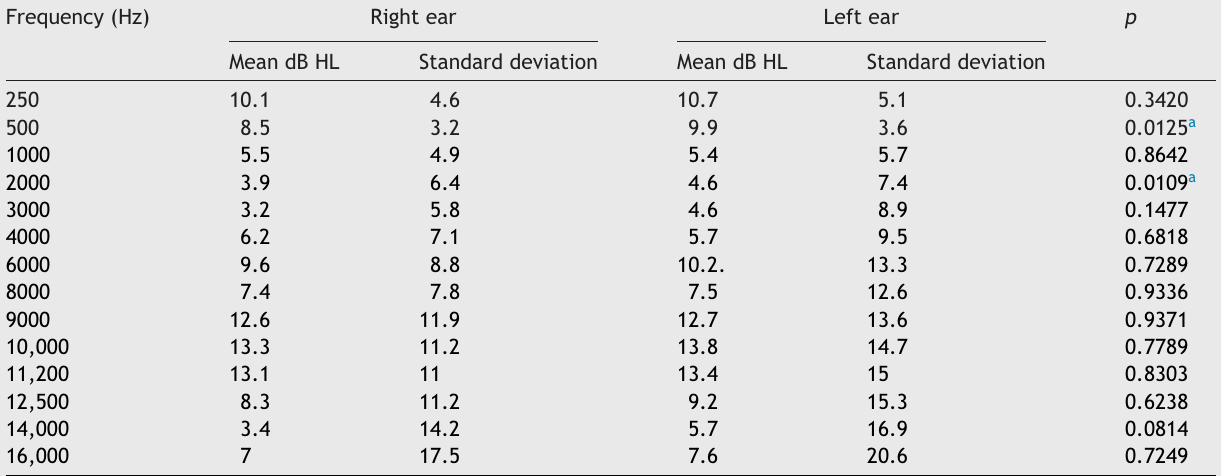
Mean conventional and high frequency pure-tone air-conduction hearing thresholds of right and left ears, per frequency, in G1 ( n =